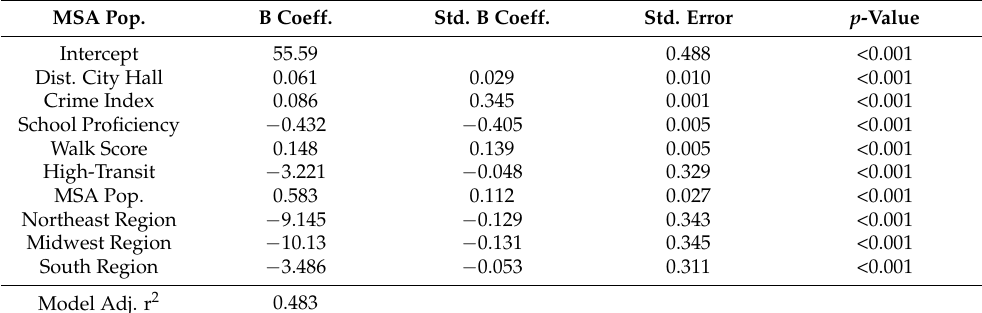
Table 1. Regression results with the social vulnerability (SV) index as the dependent variable. MSA Pop.